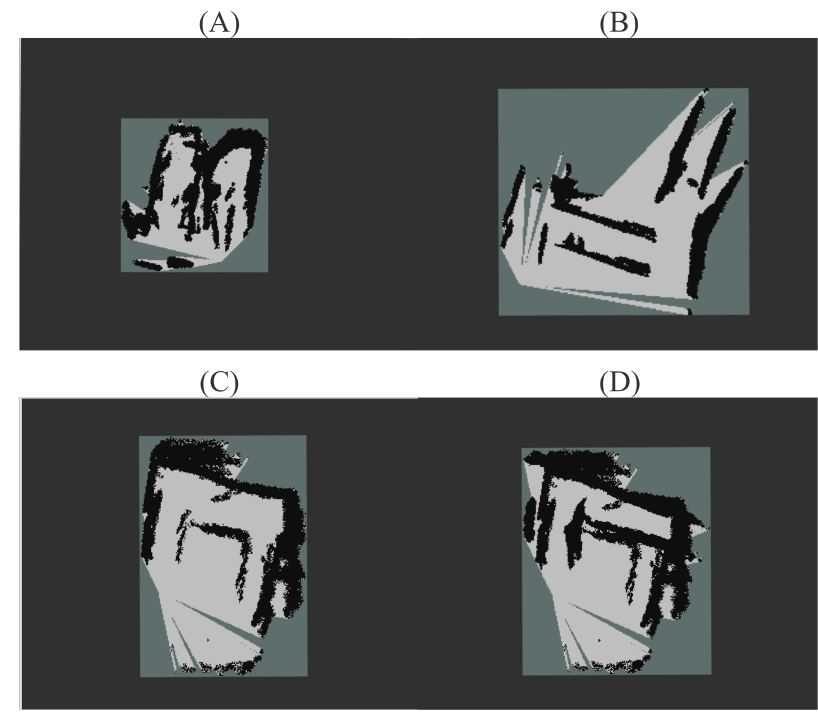
Figure 10. Example of the generated occupancy grid map of ( A ) the U-shaped hallway; ( B ) the H-shaped hallway; ( C ) the Loop-shaped hallway; ( D ) the T-shaped